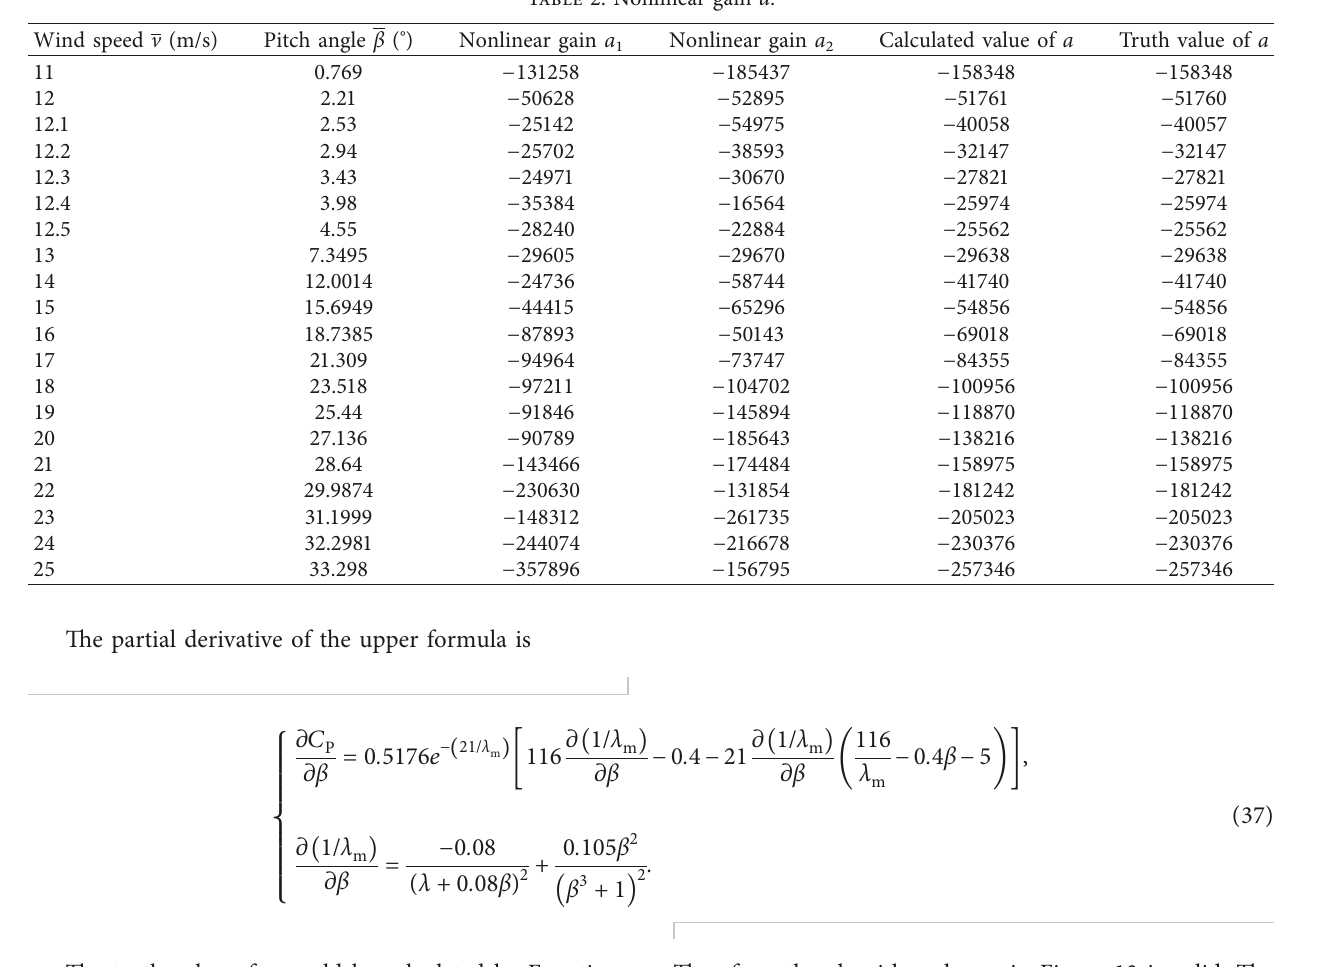
Table 2: Nonlinear gain a